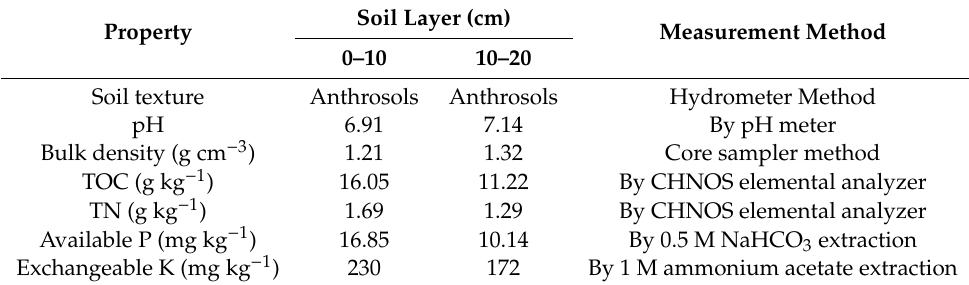
Table 1. Soil properties in di ff erent soil layers at the start of the experiment.